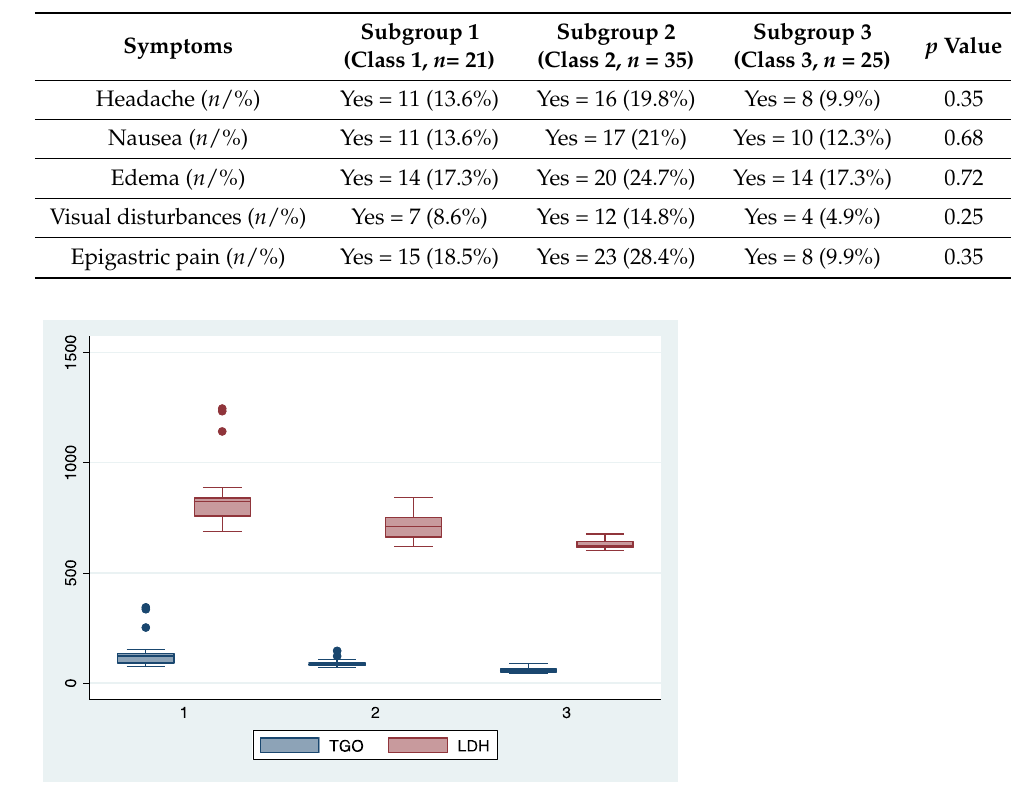
Figure 1. Boxplot representing the comparison of AST (TGO) and LDH serum valued in the subgroups 1, 2, and 3. Legend: LDH—lactate dehydrogenase; TGO—asparate aminotransferase.